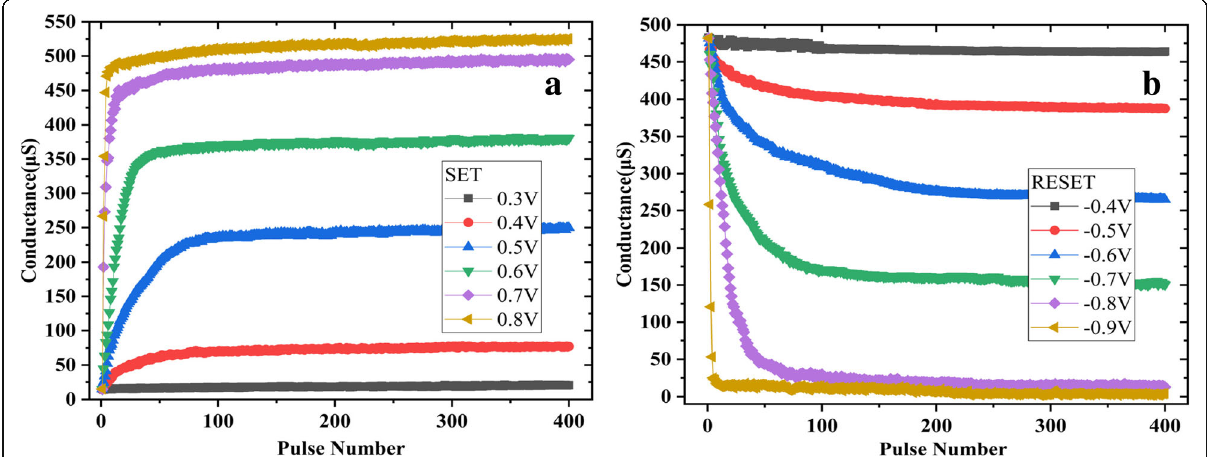
Fig. 6 The resistance adjusted by consecutive pulses. a Set process and b reset